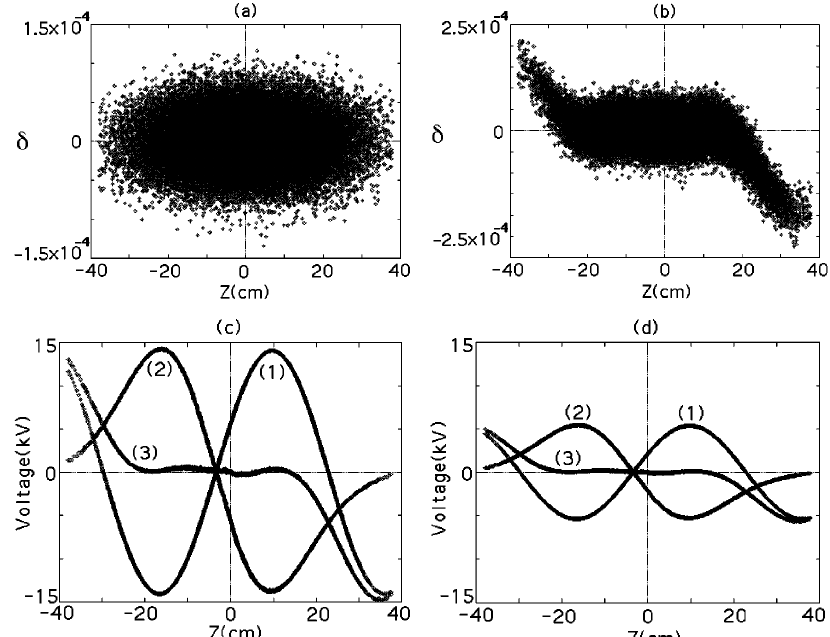
FIG. 2. The longitudinal beam phase space at (a) turn 1 and (b) turn 1000 with (cid:86) (cid:114)(cid:102)(cid:49) (cid:173) (cid:49)(cid:52)(cid:46)(cid:49) kV and (cid:86) (cid:114)(cid:102)(cid:50) (cid:173) (cid:48) . (c) (turn 1) and (d) (turn 1000) show the voltages of the rf [curve (1)], the bunch wake [curve (2)], and total voltage across the bunch [curve (3)]. The bunch wake is partly compensated for by the rf voltage, but the tails of the bunch are distorted by the rf. The difference between (c) and (d) is a consequence of the decay of the muons and the rf voltage. The parameters are s d (cid:173) (cid:51) 3 (cid:49)(cid:48) 2 (cid:53) , (cid:173) (cid:49)(cid:52)(cid:46)(cid:49) kV, (cid:86) (cid:173) (cid:48) , (cid:102) (cid:173) (cid:53)(cid:55)(cid:48) MHz, and f (cid:173) (cid:51)(cid:46)(cid:53)(cid:53) rad. j (cid:173) (cid:48)(cid:46)(cid:49) V , (cid:86) h (cid:49) (cid:173) 2 (cid:49) 3 (cid:49)(cid:48) 2 (cid:54) , j (cid:90) k (cid:114)(cid:102)(cid:49) (cid:114)(cid:102)(cid:50) (cid:114)(cid:102)(cid:49) (cid:49) (cid:110) (cid:104)